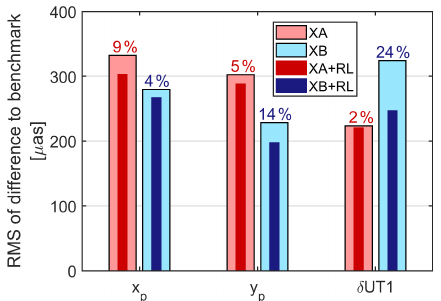
Figure 4. RMS of ERP differences between reduced network and benchmark solutions, including percentage of RMS reduction due to ring laser combination.